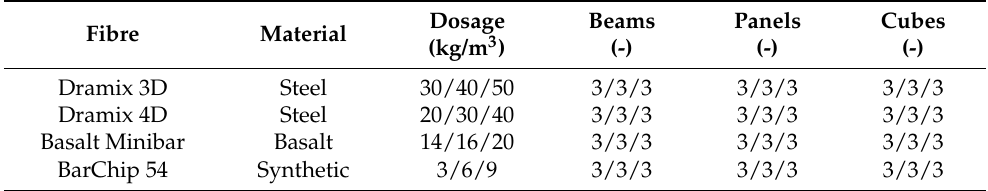
Table 4. Shotcrete mix.